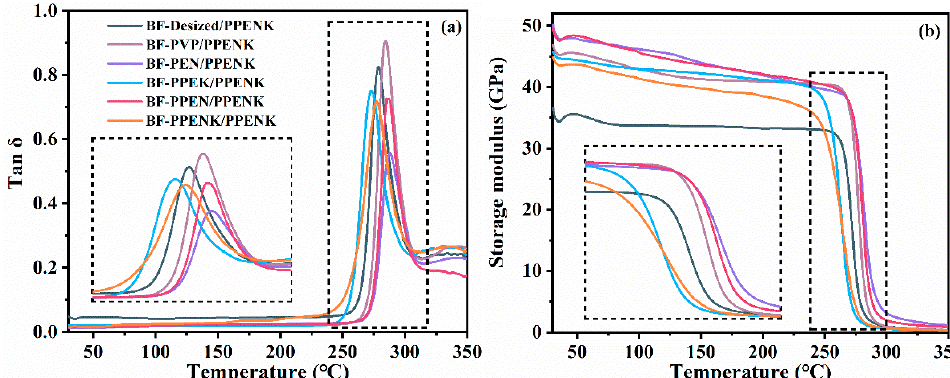
Figure 2. Dynamic thermomechanical analysis of the BF—Desized/PPENK, BF-PVP/PPENK, BF-PEN/PPENK, BF-PPEK/PPENK, BF-PPEN/PPENK and BF-PPENK/PPENK composites; ( a ) loss factor curves and ( b ) storage modulus curves.